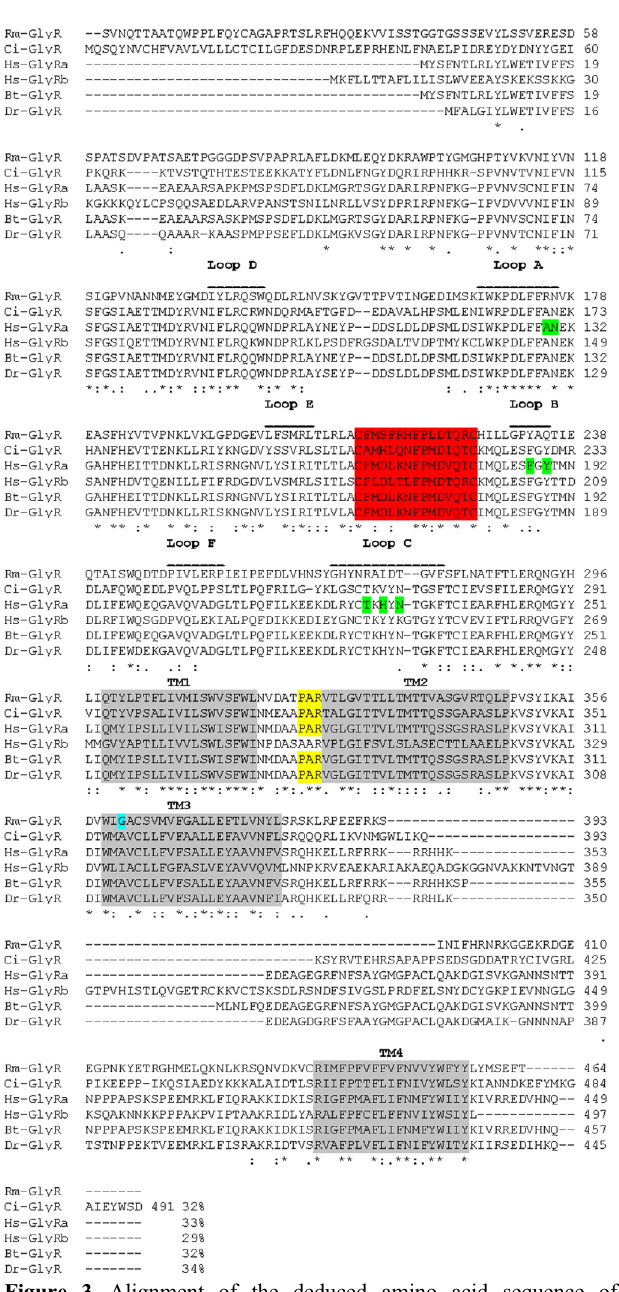
Figure 3. Alignment of the deduced amino acid sequence of GlyR from R. microplus (KJ476181), GlyR from C. Intestinalis (BAI66458), GlyRa (NP_000162) and GlyRb (NP_000815) from H. sapiens , GlyR from B. taurus (NP_776746), and GlyR from D. rerio (NP_571477). The cysteines forming the Cys-loop are highlighted by red shading and the putative membrane domains (TM1–TM4) are highlighted by gray shading. The PAR residues are highlighted in yellow shading. The glycine residue marked in turquoise likely confers upon the receptor high sensitivity to ivermectin. The approximate locations of the glycine binding domains are labeled as A-F. Known residues in human GlyRa that play a role in glycine binding are highlighted in green [22].